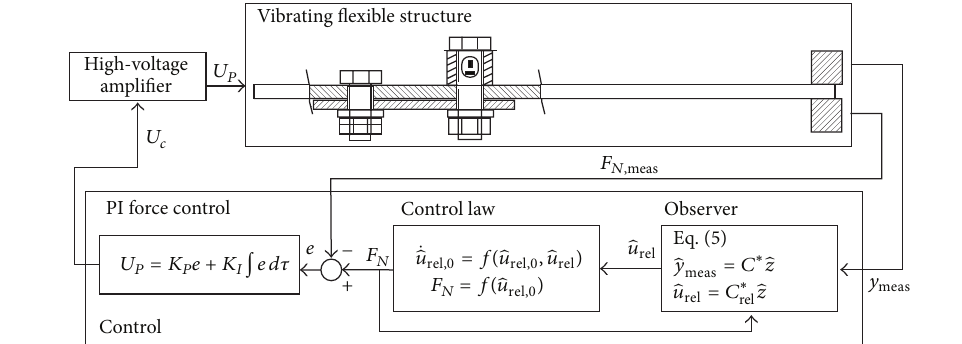
Figure 6: Closed control loop with hysteresis-optimal control law.